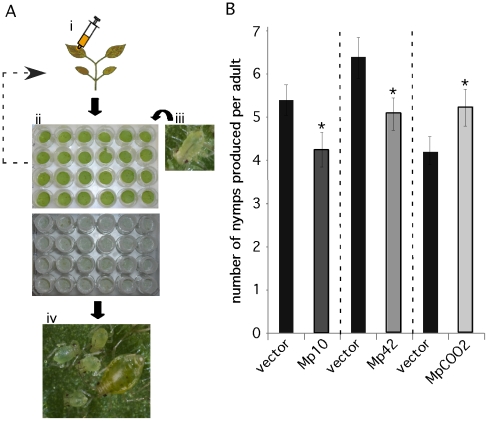
A medium-throughput leaf disc-based assay identifies M. persicae effector candidates that affect aphid performance.(A) A novel medium-throughput assay to determine whether in planta overexpresssion of effector candidates affects aphid performance. i) Effector candidates are overexpressed in Nicotiana benthamiana by agroinfiltration. ii) One day after agroinfiltration leaf discs are harvested from infiltration sites using a cork borer. Leaf discs are placed upside-down on water agar in a 24-wells plate. iii) Four first-instar nymphs are placed on each leaf disc and wells are covered with individual mesh caps. Every six days these four aphids are moved to fresh leaf discs overexpressing the effector candidates. iv) Nymph production is assessed up to 17 days after placing first-instar nymphs on the leaf discs on day 1. (B) Overexpression of Mp10 and Mp42 reduces aphid nymph production (fecundity) and overexpression of MpC002 increases aphid nymph production. For each effector candidate, agroinfiltrations and aphid assays were performed side-by-side with the vector control (vector). Graphs show the average number of nymphs produced per adult based on 3 replicated experiments, each consisting of 6 replicated leaf discs per candidate effector construct (n = 18). Error bars indicate the standard error. Asterisks indicate statistical significance compared to the vector control based on a one-way ANOVA (Mp10: p≤0.026, Mp42: p≤0.036 and MpCOO2: p≤0.038).